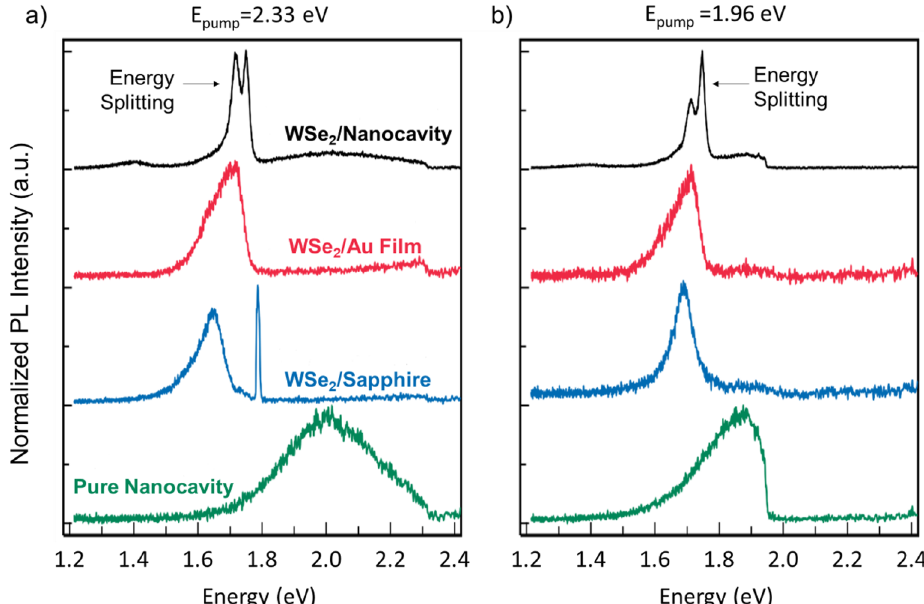
Figure 2. PL emission from monolayer WSe 2 embedded in different configurations at a temperature of 77 K. The CW pump laser has energy of 2.33 eV ( a ) and 1.96 eV ( b ). The configurations consist of plasmonic nanocavity (WSe 2 /Nanocavity), monolayer WSe 2 on gold-film substrate (WSe 2 /Au Film), monolayer WSe 2 on sapphire (WSe 2 /Sapphire) and pure plasmonic nanocavity (Pure Nanocavity). The PL measurements were conducted with a laser power of 20